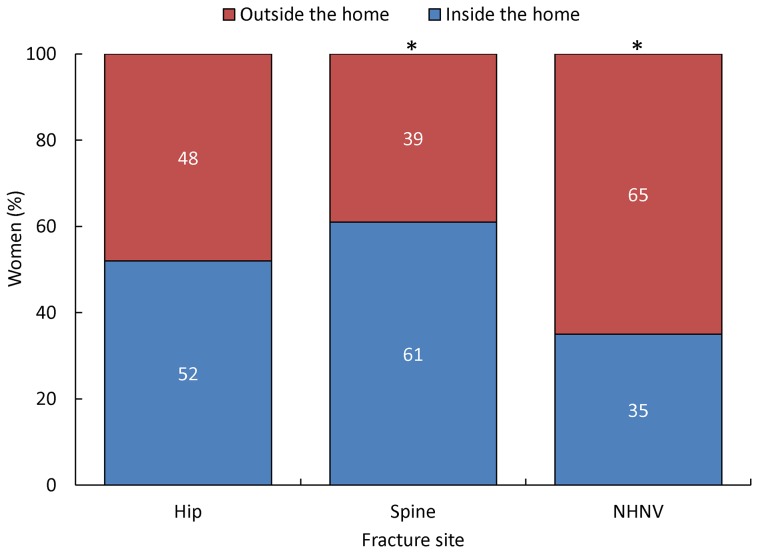
Location of occurrence of fracture by fracture type.Significant differences for each location within fracture types (P<0.05) are denoted by an asterisk. NHNV, non-hip, non-vertebral.